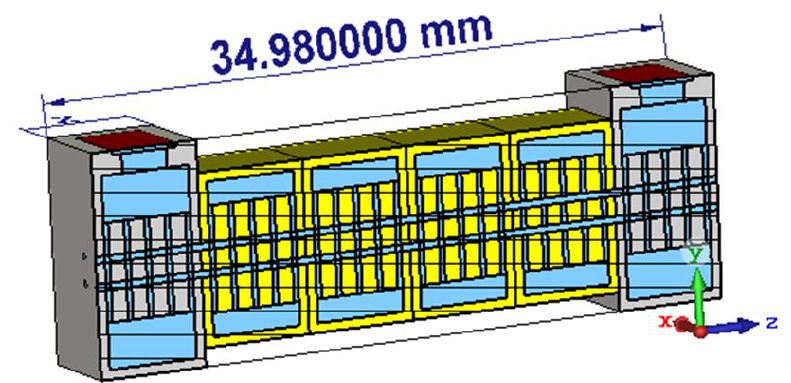
Electronics 2022 , 11 , x FOR PEER REVIEW Figure 12. Cut-plane of RF section of Ka-band ladder-type multibeam EIK. Figure 12. Cut-plane of RF section of Ka-band ladder-type multibeam EIK.